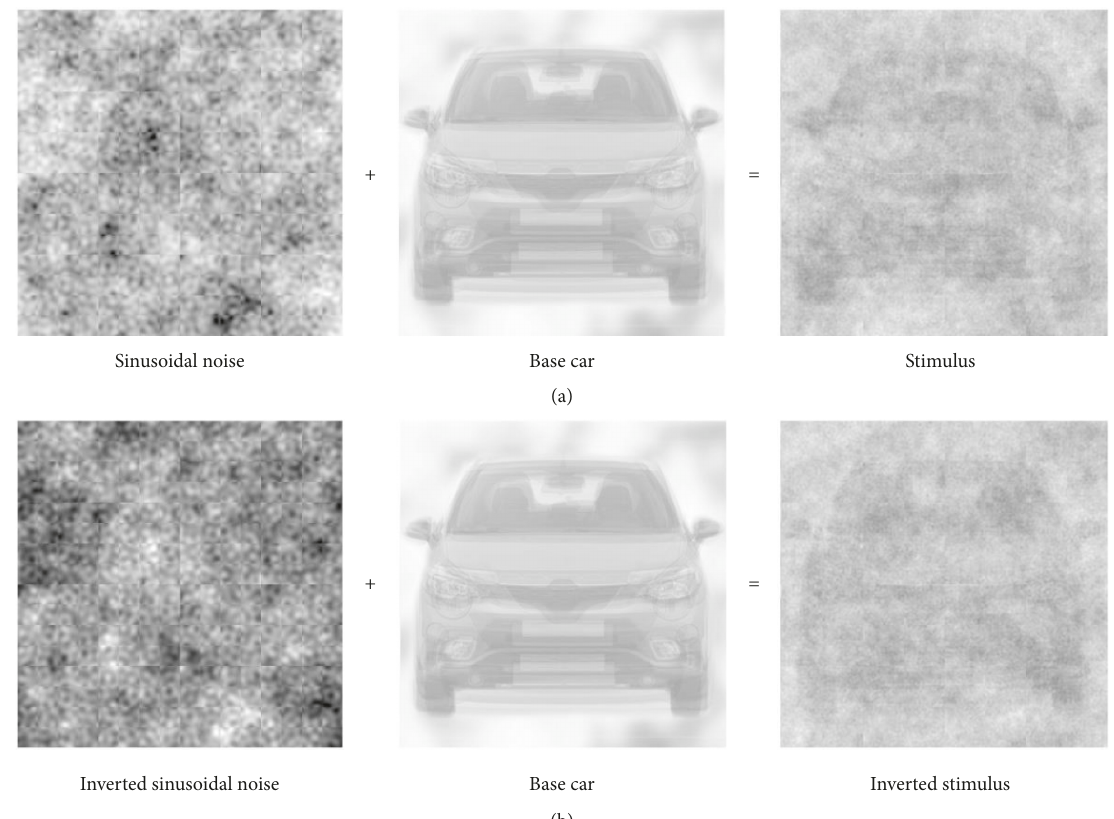
Figure 2: Sinusoidal noise is applied to the base image to obtain a stimulus (a). The inverted stimulus is obtained by applying the inverted noise to the base image